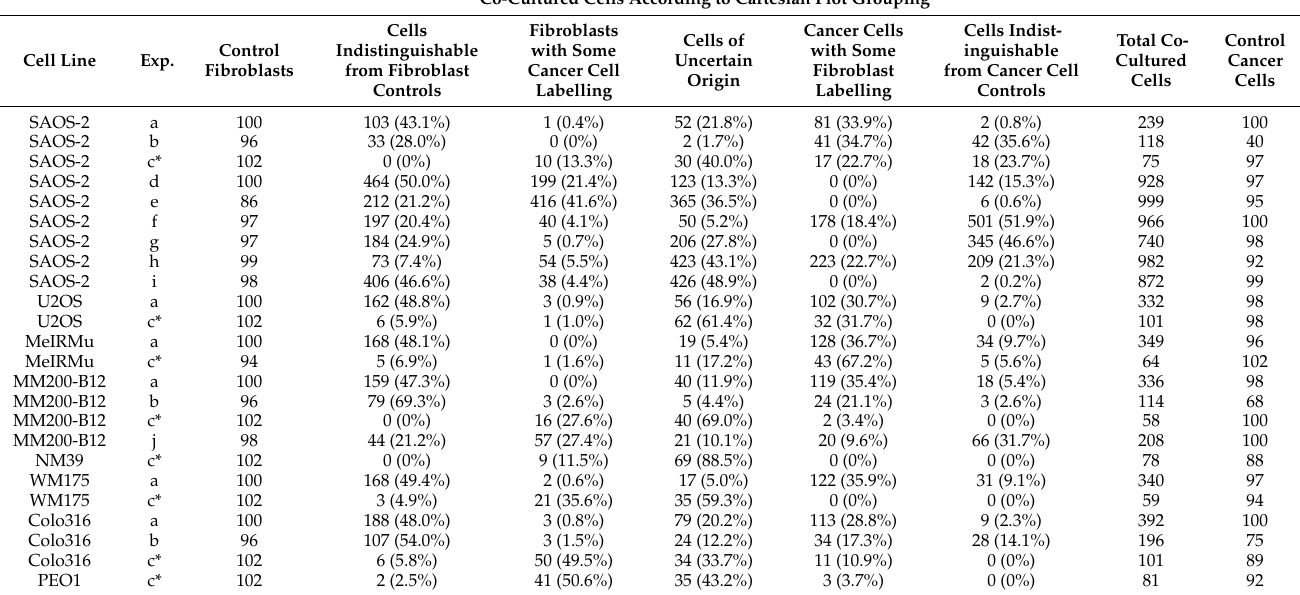
Table 1. The number of co-cultured cells according to Cartesian plot grouping, as well as of control cells cultured in isolation, in each experiment. The relative percentage of cells in each co-cultured group is indicated in brackets (%) to aid comparison. Ostesoarcoma (SAOS-2, U2OS), melanoma (MeIRMu, MM200-B12, NM39, WM175), colon carcinoma (Colo316) and ovarian carcinoma (PEO1) cells were studied. All experiments were with human dermal fibroblasts, labelling fibroblasts with DiD and cancer cell lines with DiO, except for experiment ‘i’ where SAOS-2 expressed GFP, and experiment ‘c’ (marked *), where human gingival fibroblasts were used and labelling had the opposite orientation, such that fibroblasts were pre-labelled with DiO and cancer cells with DiD. Co-Cultured Cells According to Cartesian Plot Grouping